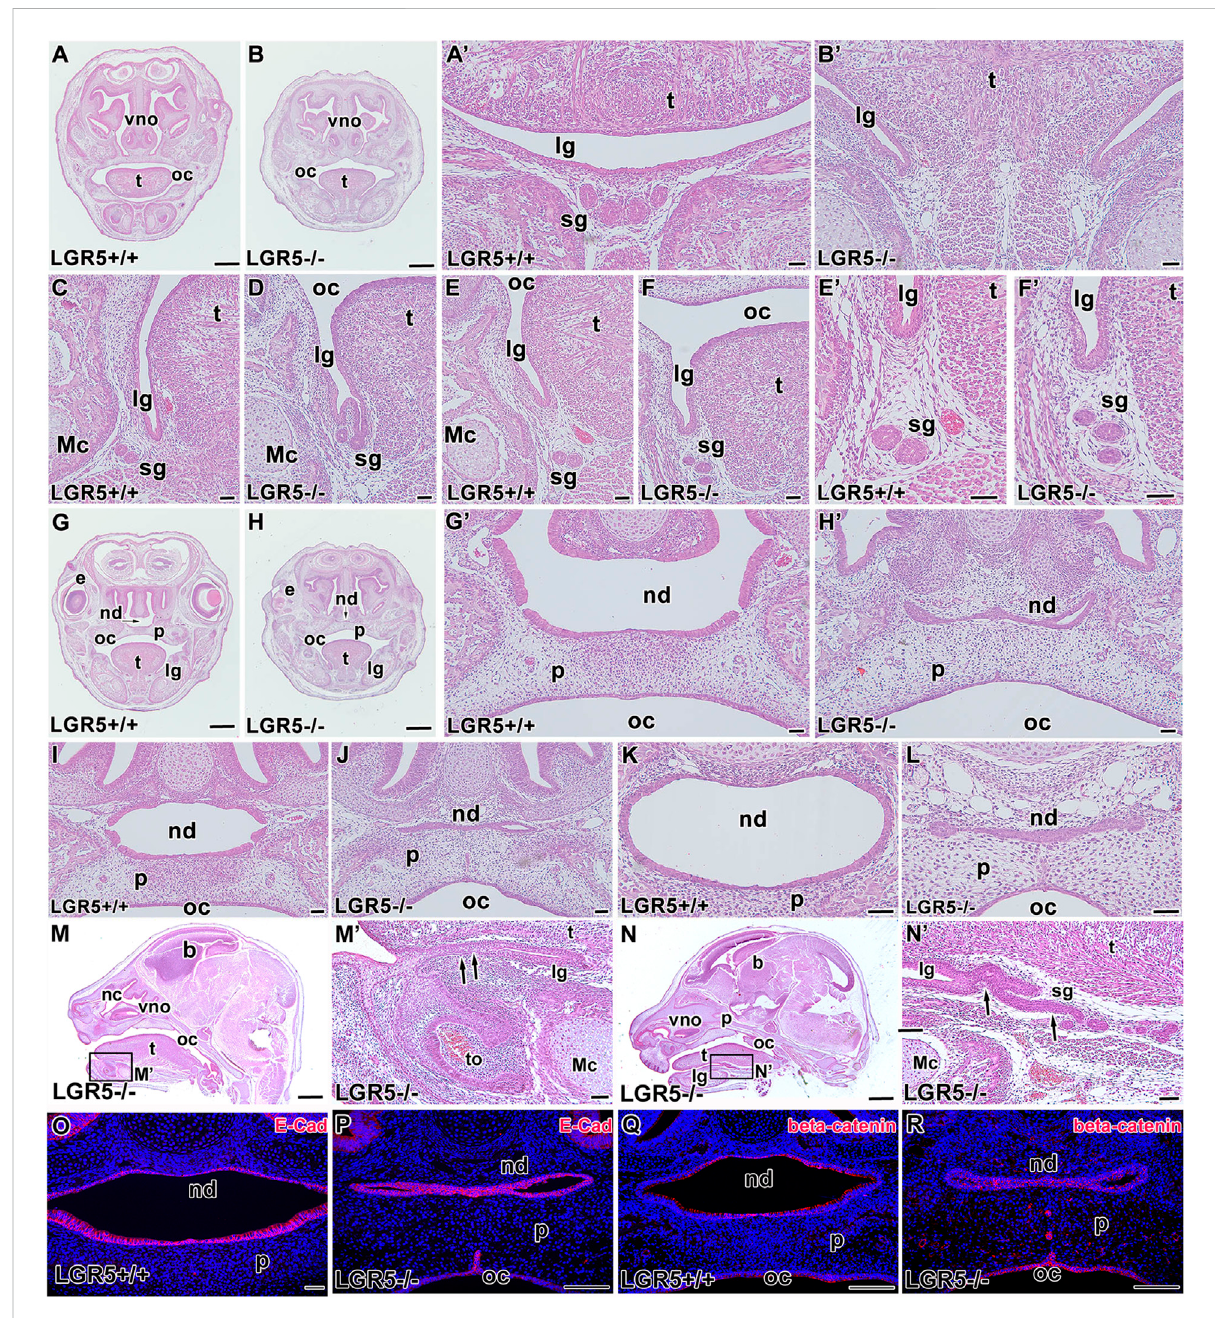
FIGURE 10 Craniofacialabnormalitiesof Lgr5 − / − miceatE16.5. Lgr5 -de fi cientmiceexhibitseveraldistinctcraniofacialdefects (A-L) asshownontransversal histological sections of Lgr5 -de fi cient mice stained by Hematoxylin-Eosin. Low magni fi cation of transversal section of rostral area in Lgr5 +/+ (A) and Lgr5 − / − (B) mice. High magni fi cation of tongue area in WT embryo (A´) and Lgr5 -de fi cient embryo with distinct ankyloglossia (B´) . No craniofacial defectscanbeobservedintheareaoflingualgrooveatWTembryo (C,E,E´) .Branchingofepithelium (D) andmultiplicationofoutletsofsalivary glands (F,F´) was observed in Lgr5 -de fi cient mice. Low-magni fi cation image of palate area of Lgr5 +/+ (G) and Lgr5 − / − (H) mice. High magni fi cation of developing palate with correctly formed nasopharyngeal duct (G´) . Abnormal morphology of nasopharyngeal duct in mutant embryo (H´) . Histological section of middle area of nasopharyngeal duct of Lgr5 +/+ (I) and the atypically formed nasopharyngeal duct of Lgr5 − / − embryos (J) . The caudal area of the nasopharyngeal duct in WT embryo (K) and mutant embryo (L) . (M – N) Sagittal sections through the head display tongue fusion withmouth fl oor (M´) ordysregulationofsalivaryglanddevelopment (N´) .TheexpressionofE-cadherinisnotchangedin Lgr5 +/+ (O) and Lgr5 − / − (P) . Expression of β -catenin is decreased indeveloping nasopharyngeal duct area in Lgr5 − / − incontrast to WT animal (Q, R) . Nuclei are counterstained by DAPI (Blue). e, eye; lg, lingual groove; Mc, Meckel ’ s cartilage; nd, nasopharyngeal duct; oc, oral cavity; p, palate; sg, salivary gland; t, tongue; vno, vomeronasal organ. Scale bars for A, B. G, H, M, N μ 1 mm. Scale bars for others = 100 μ